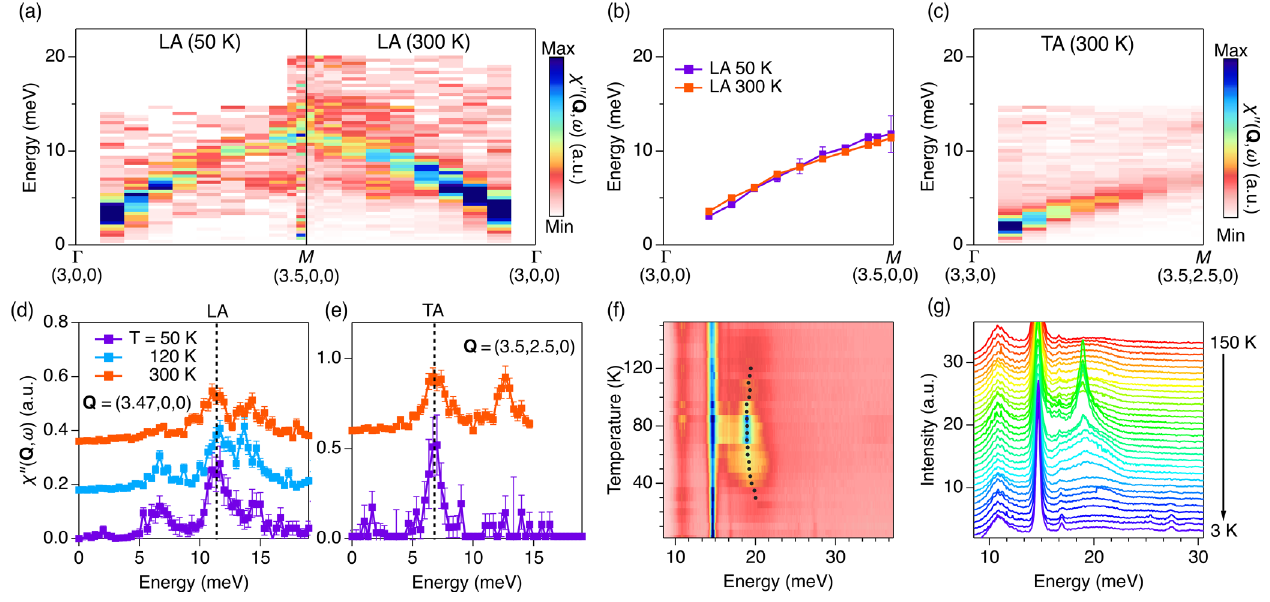
FIG. 3. Evidence of unconventional electronically driven CDW. (a) compares the IXS determined LA of RbV 3 Sb 5 along Γ ð 3 ; 0 ; 0 Þ to ¼ 103 K). (b) Extracted-temperature-dependent phonon dispersions from M ð 3 . 5 ; 0 ; 0 Þ at temperatures of T ¼ 300 K and 50 K ( T CDW (a). (c) TA in RbV 3 Sb 5 measured along Γ ð 3 ; 3 ; 0 Þ to M ð 3 . 5 ; 2 . 5 ; 0 Þ at room temperature (300 K). (d) and (e) compare temperature- dependent IXS spectra at Q ¼ ð 3 . 47 ; 0 ; 0 Þ and (3.5,2.5,0). The dashed lines in (d) and (e) highlight LA and TA, respectively. All IXS data are Bose-factor corrected, and the elastic contribution at ω ¼ 0 is subtracted by fitting the IXS raw data (see Supplemental Material [31]). (f),(g) Temperature-dependent Raman spectra on CsV 3 Sb 5 from 150 to 3 K. Beside the sharp optical phonon peak at 11, 15, and 17 meV, there is a continuum that is broadly centered near 19 meV (the 11-meV peak may actually be at lower energy but appears to be at 11 meV due to the cutoff of the longpass filter at 11 meV). The black dots in (f) mark the peak positions of the continuum near 19 meV. When cooling toward T , the center of this continuum gradually shifts from 19.5 to 19 meV and starts to build a strong, CDW ¼ 94 K. Moving to lower temperature, this peak is quickly damped and hardened to 20 meV at sharp, and asymmetric peak at T CDW 30 K. Below 30 K, two new phonon modes at 25.4 and 27.5 meVare observed, which may correspond to the stripe phase observed by a recent STM study [16]. The error bars in panels (d),(e) represent 1 standard deviation assuming Poisson counting statistics. The error bars in panel (b) denote the 2 σ returned from the fitting that extracts the spectral peak